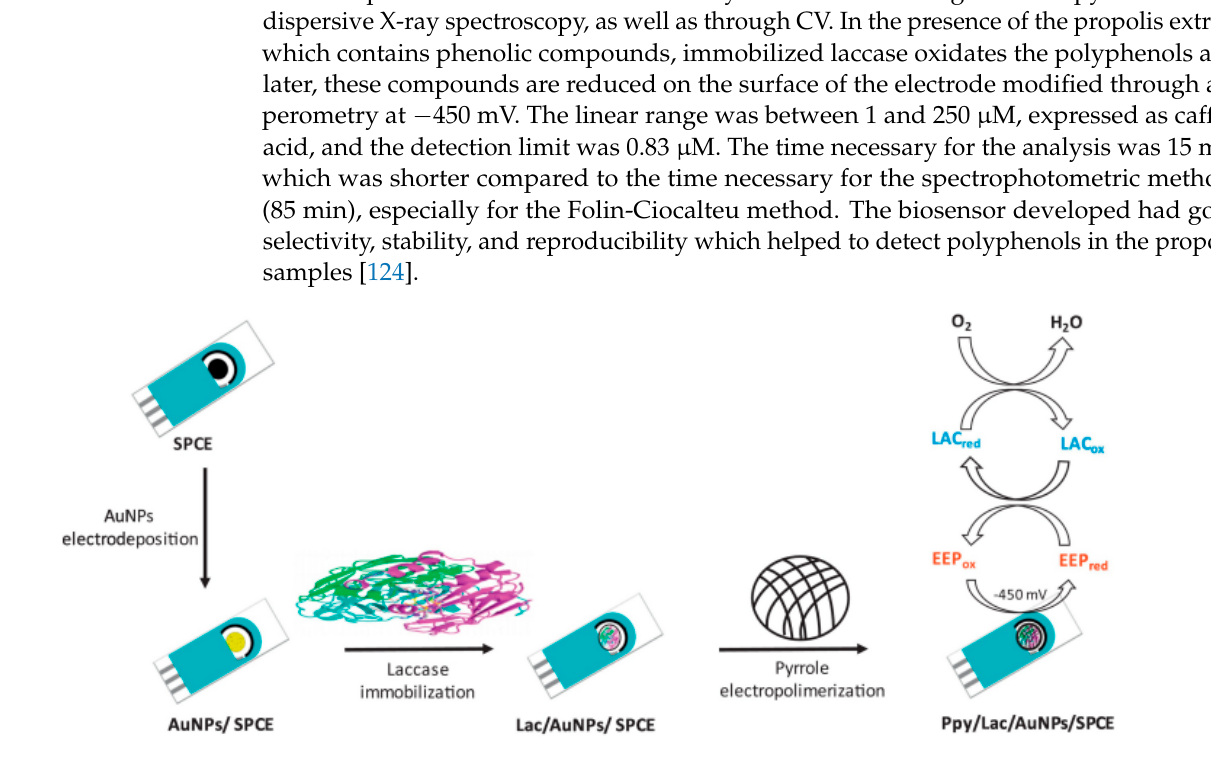
Figure 7. A schematic representation of SPCE modified with a Ppy/Lac/AuNPs nanocomposite film for the quantification of polyphenols in propolis samples. Published from [124] with the permission of the publisher.